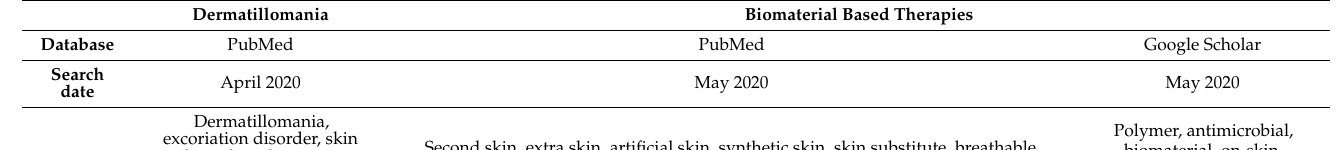
Table 1. Literature search